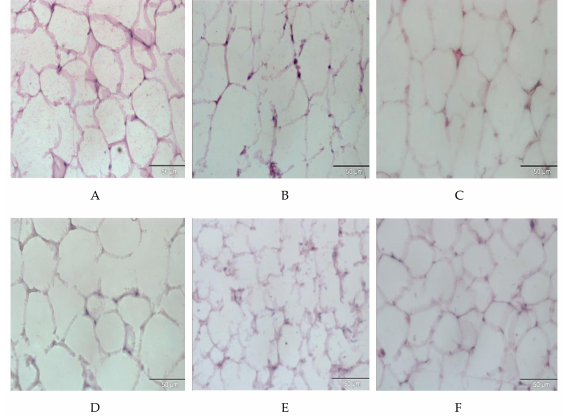
Figure 3. Histopathological analysis of RpWAT (scale bar 50 µ m) for the ( A ) NC group, ( B ) PC group, ( C ) DC group, ( D ) T I group, ( E ) T II group, and ( F ) T III group. NC: normal control; PC: positive control; DC: drug control; T I: treatment 1 (10 mg · kg − 1 ); T II: treatment 2 (100 mg · kg − 1 ); T III: treatment 3 (200 mg · kg − 1